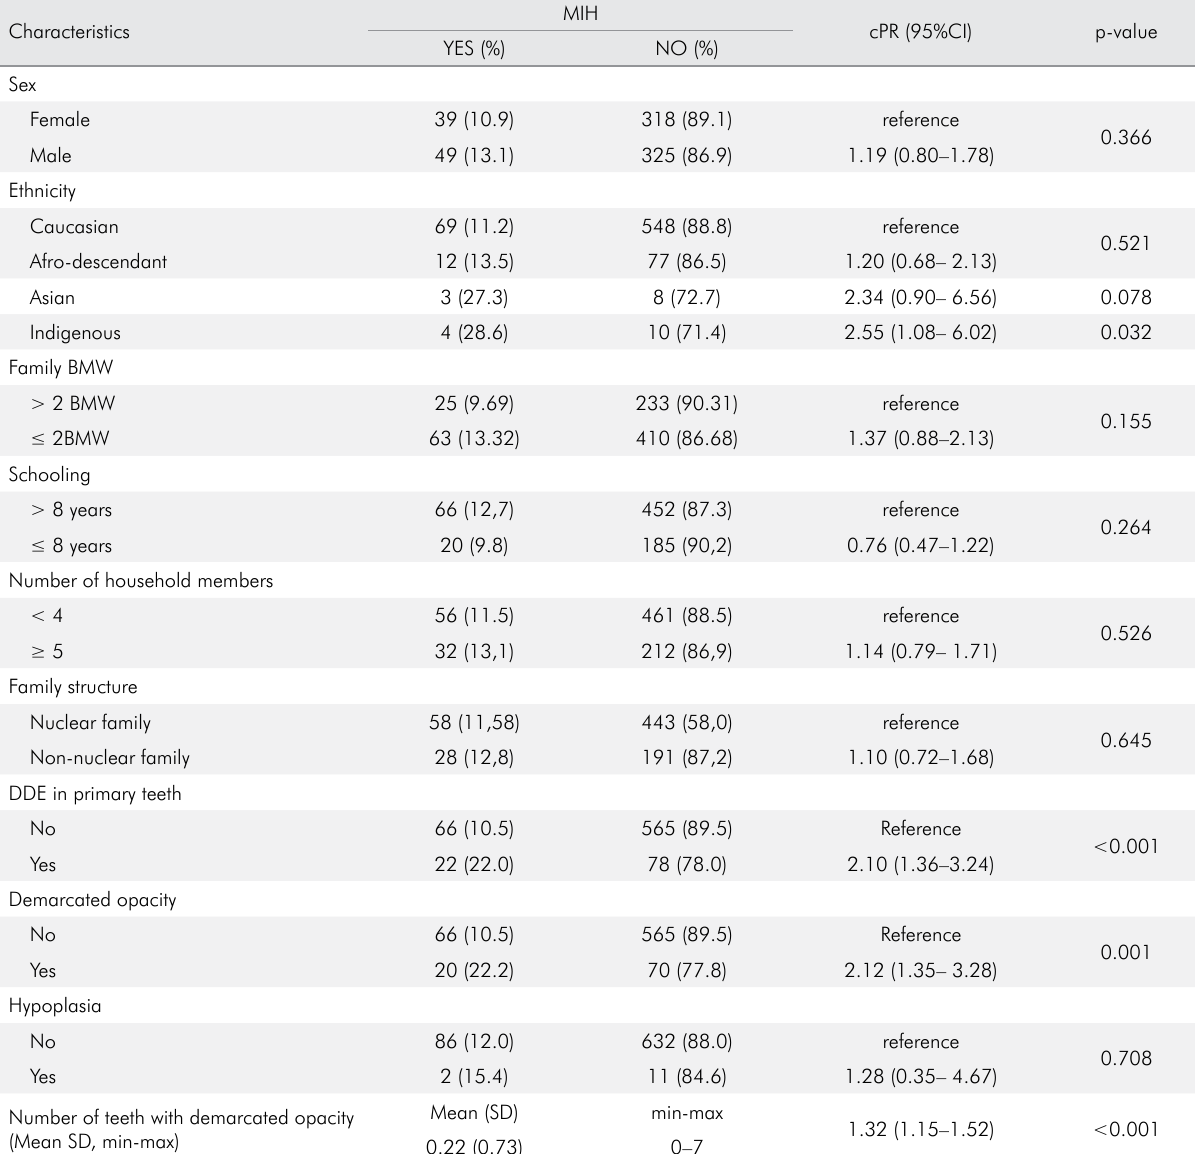
Table 3. Crude Prevalence ratio (cPR) of MIH according to DDE in primary teeth and socioeconomic characteristics of the sample (Curitiba, Brazil,